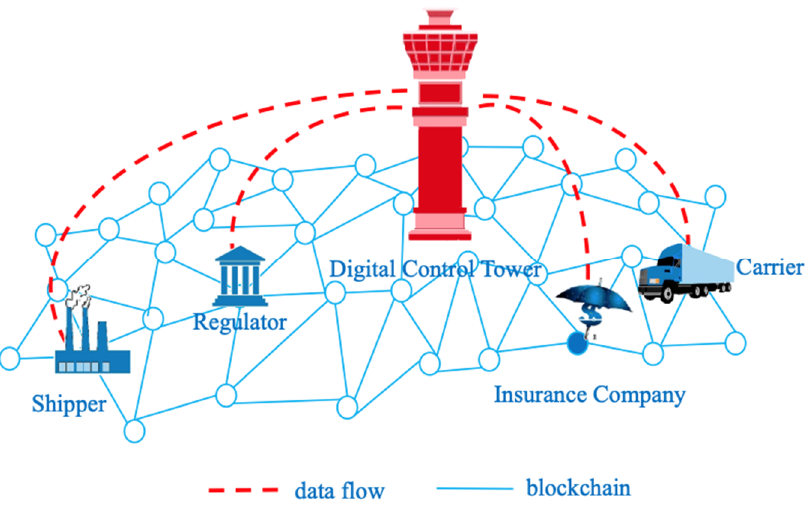
Figure 3. A transportation control tower running on a blockchain network.